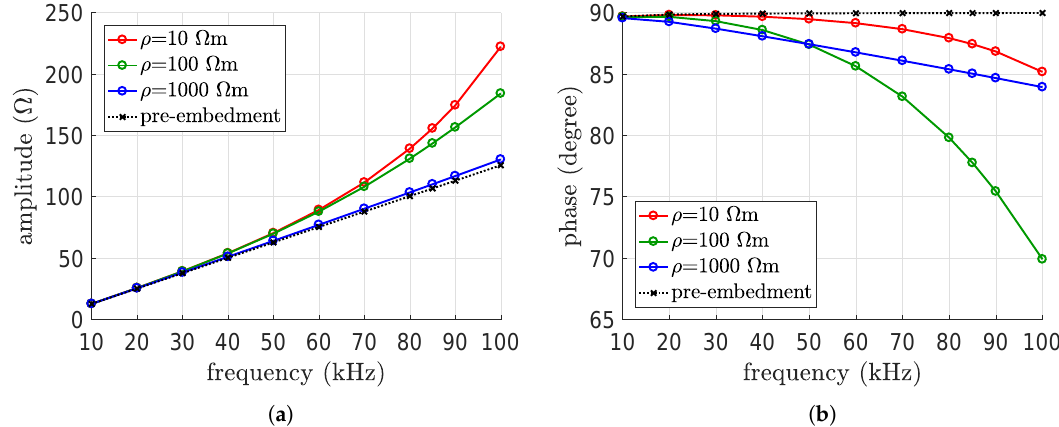
Figure 22. Equivalent impedance of the embedded coil ( Mod1 ) vs. frequency parametrized for ρ equal to 10 Ω m, 100 Ω m, and 1000 Ω m. Amplitude ( a ); phase ( b ).